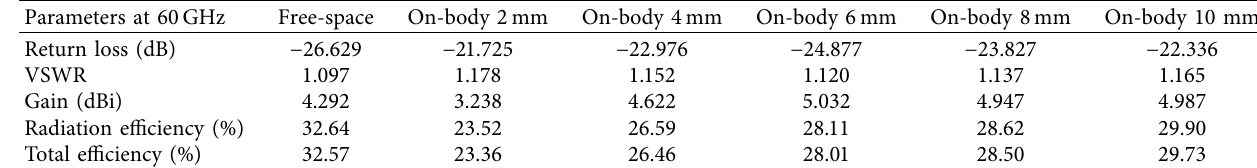
Table 9: Array 3 on-body results at different gap distances.